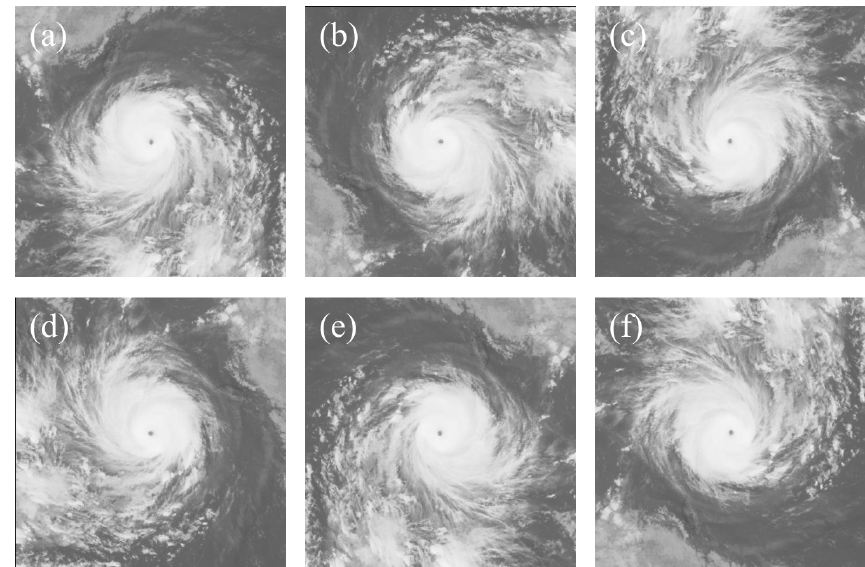
Figure 2. Image transformation showing the (a) original image followed by images that are (b) rotating 90 ◦ counterclockwise, (c) rotating 180 ◦ counterclockwise, (d) rotating 270 ◦ counterclockwise, and have a (e) horizontal flip and (f) vertical flip.